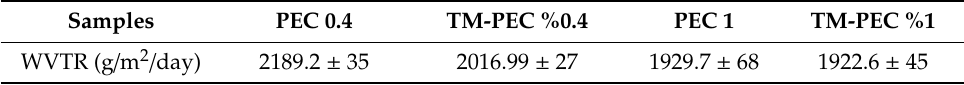
Table 2. Water vapor transmission